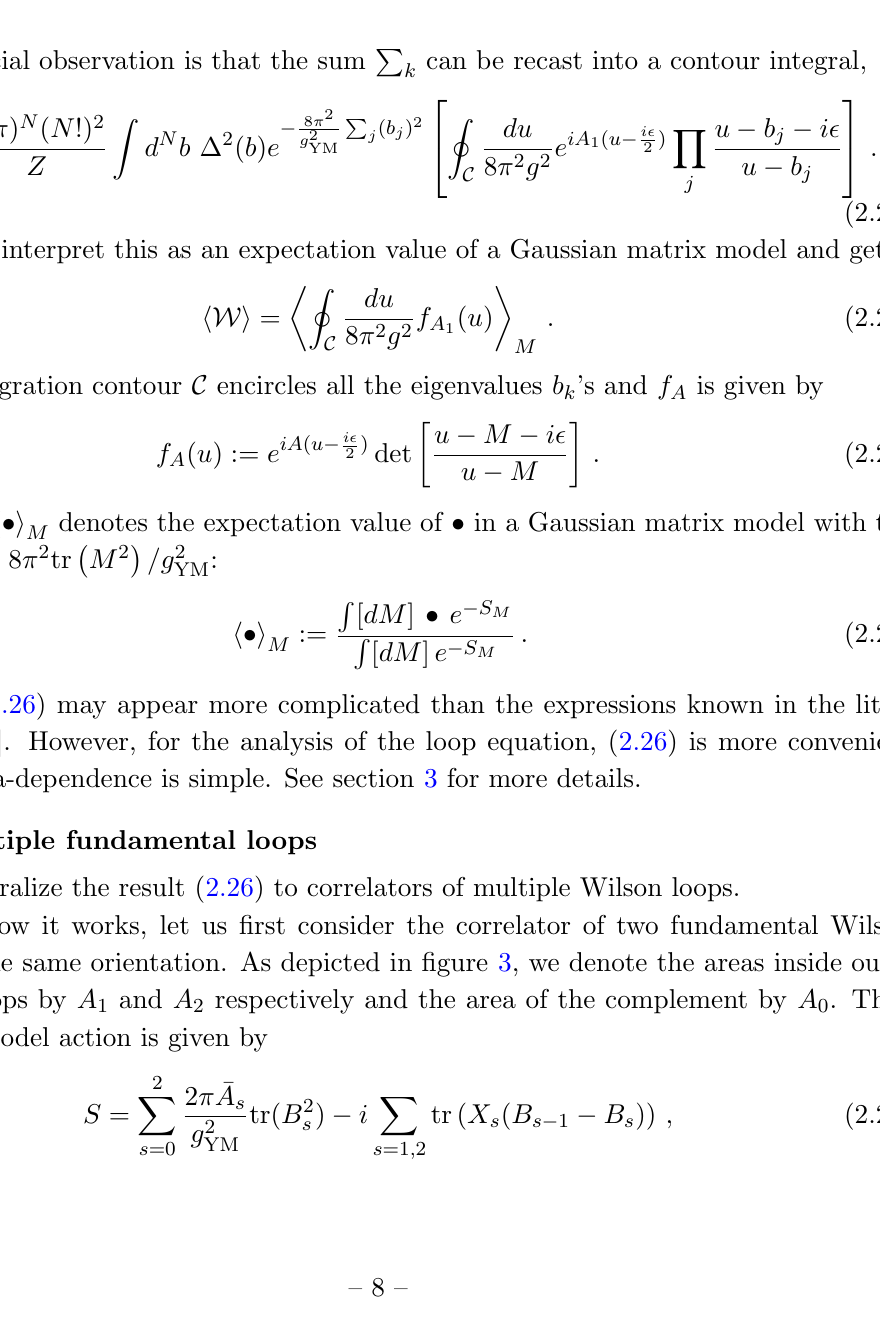
Figure 3 . Two 1 = 8-BPS loops with the same orientations. Left: the loops divide S 2 into three disconnected regions with areas (cid:22) A 0 , (cid:22) A 1 and (cid:22) A 2 . Right: the same con(cid:12)guration viewed from the south pole. We denote the areas inside outer (red) and inner (blue) circles by A 1 and A 2 respectively and the area of the complement by A 0 . The two sets of areas are related by (cid:22) A 0 = A 0 , (cid:22) A 1 = A 1 (cid:0) A 2 and (cid:22) A 2 = A 2